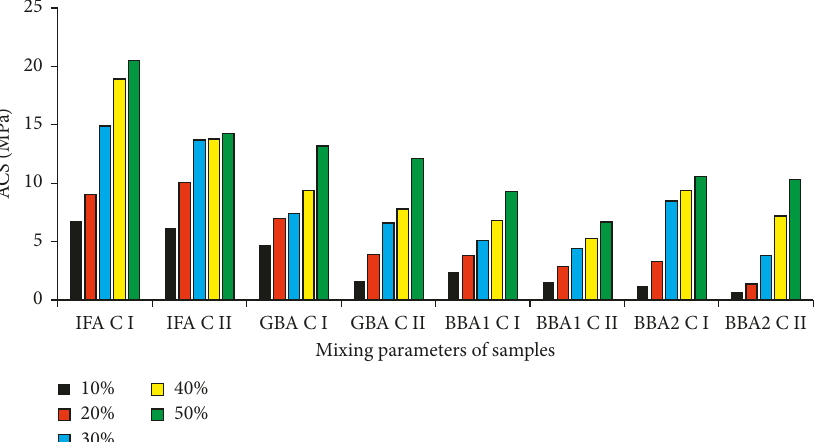
Figure 8: Relationship of ACS for FA- and BA-based sample. IFA: ˙Isken FA; C: CEM; GBA: G¨oknur BA; BBA: Bor BA.